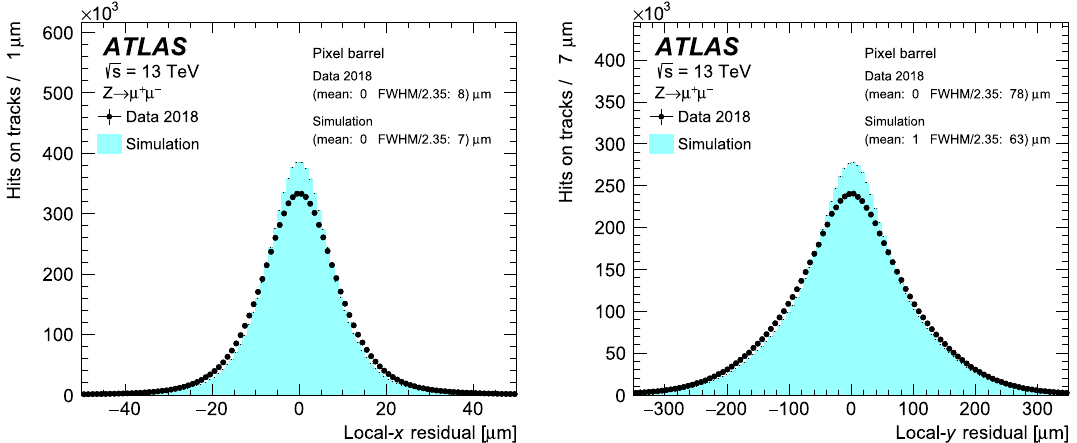
Fig. 5 The Pixel local- x (left) and local- y (right) residual distributions for the Z → μ + μ − data sample compared with simulated data. The distributions are integrated over all hits on tracks in barrel modules